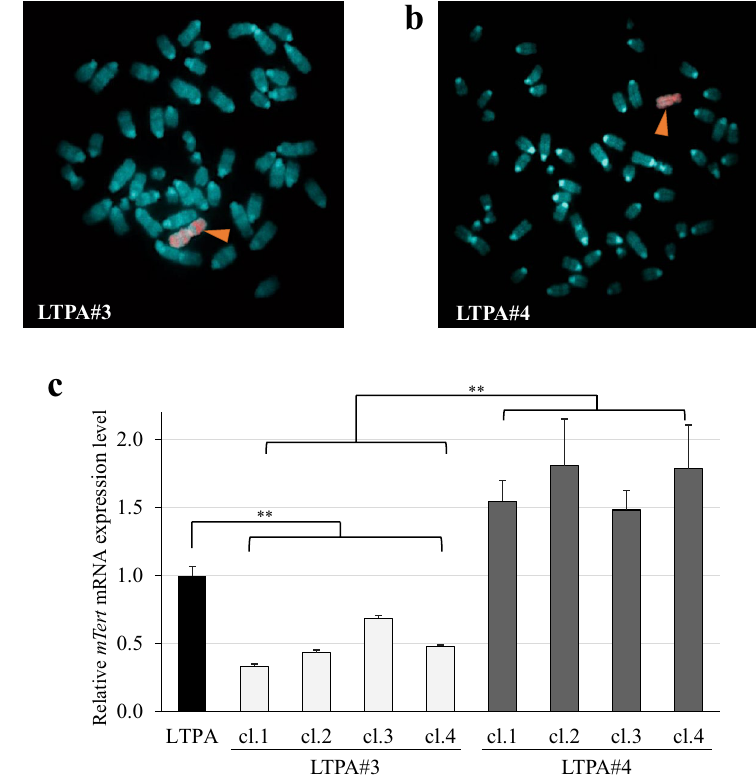
Figure 2. Suppression of mTert expression by introduction of an intact human chromosome 3 into murine LTPA cells. Fluorescence in situ hybridization (FISH) analysis of ( a ) LTPA#3 cells and ( b ) LTPA#4 cells. Rhodamine-labeled human COT-1 DNA was used as probe DNA. The arrowhead indicates a transferred human chromosome 3 or 4. ( c ) Quantitative RT-PCR analysis of relative mTert mRNA expression levels in LTPA, LTPA#3, and LTPA#4 cells. The mRNA expression of mGapdh was used as the internal control. Data are presented as means ± S.E. of three independent experiments (** P <